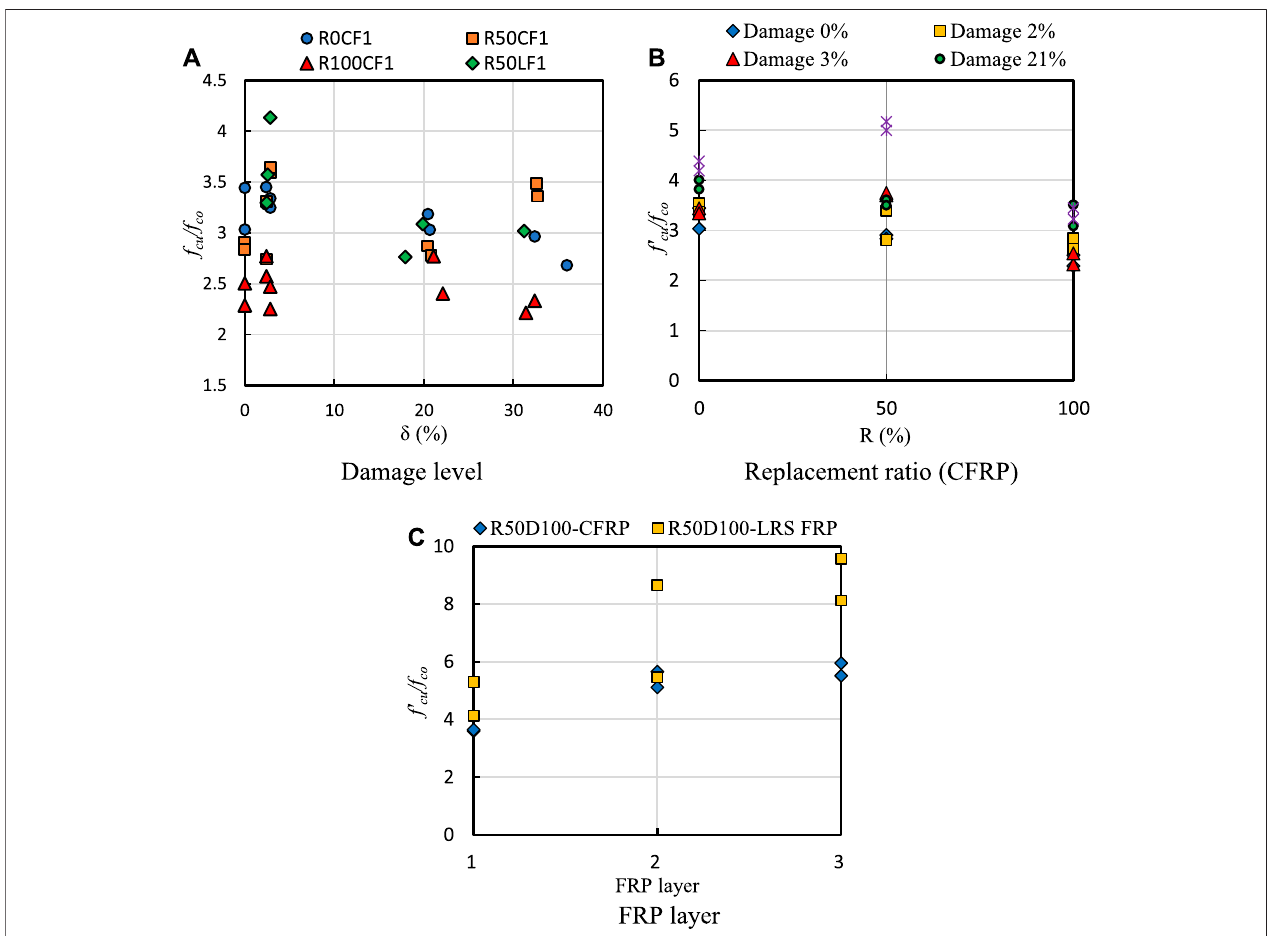
Figure 16 | Effect of damage level, replacement ratio, and FRP layer on compressive